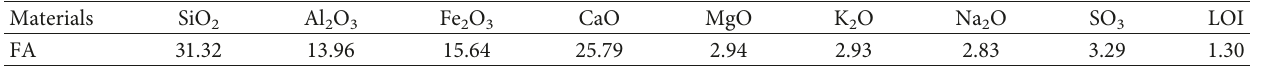
Table 1: Chemical compositions of FA (by weight).